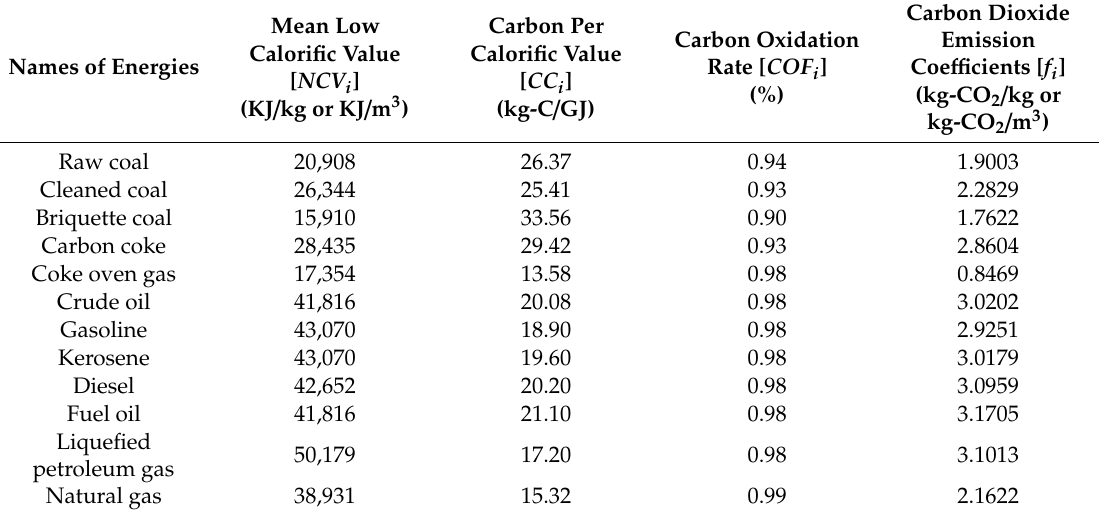
Table 1. Carbon emissions coe ffi cient of transportation and